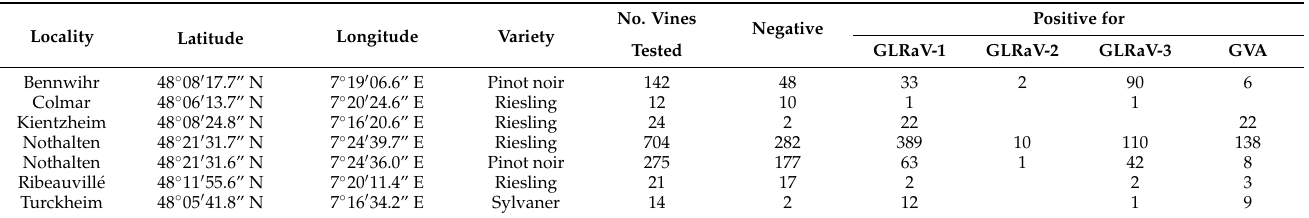
Figure 1. Graphical description of the different experiments performed. ( A ): Infectivity experiments; ( B ): Controlled transmission and retention experiments. Table 1. Location of the plots sampled for Heliococcus bohemicus populations and proportion of viruses among grapevines tested in ELISA for GLRaV-1, -2, and -3, and